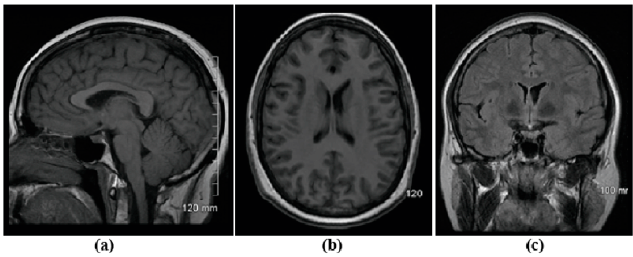
Figure 3. Brain MRI obtained from ( a ) Sagittal Plane, ( b ) Axial plane, and ( c ) Coronal plane.